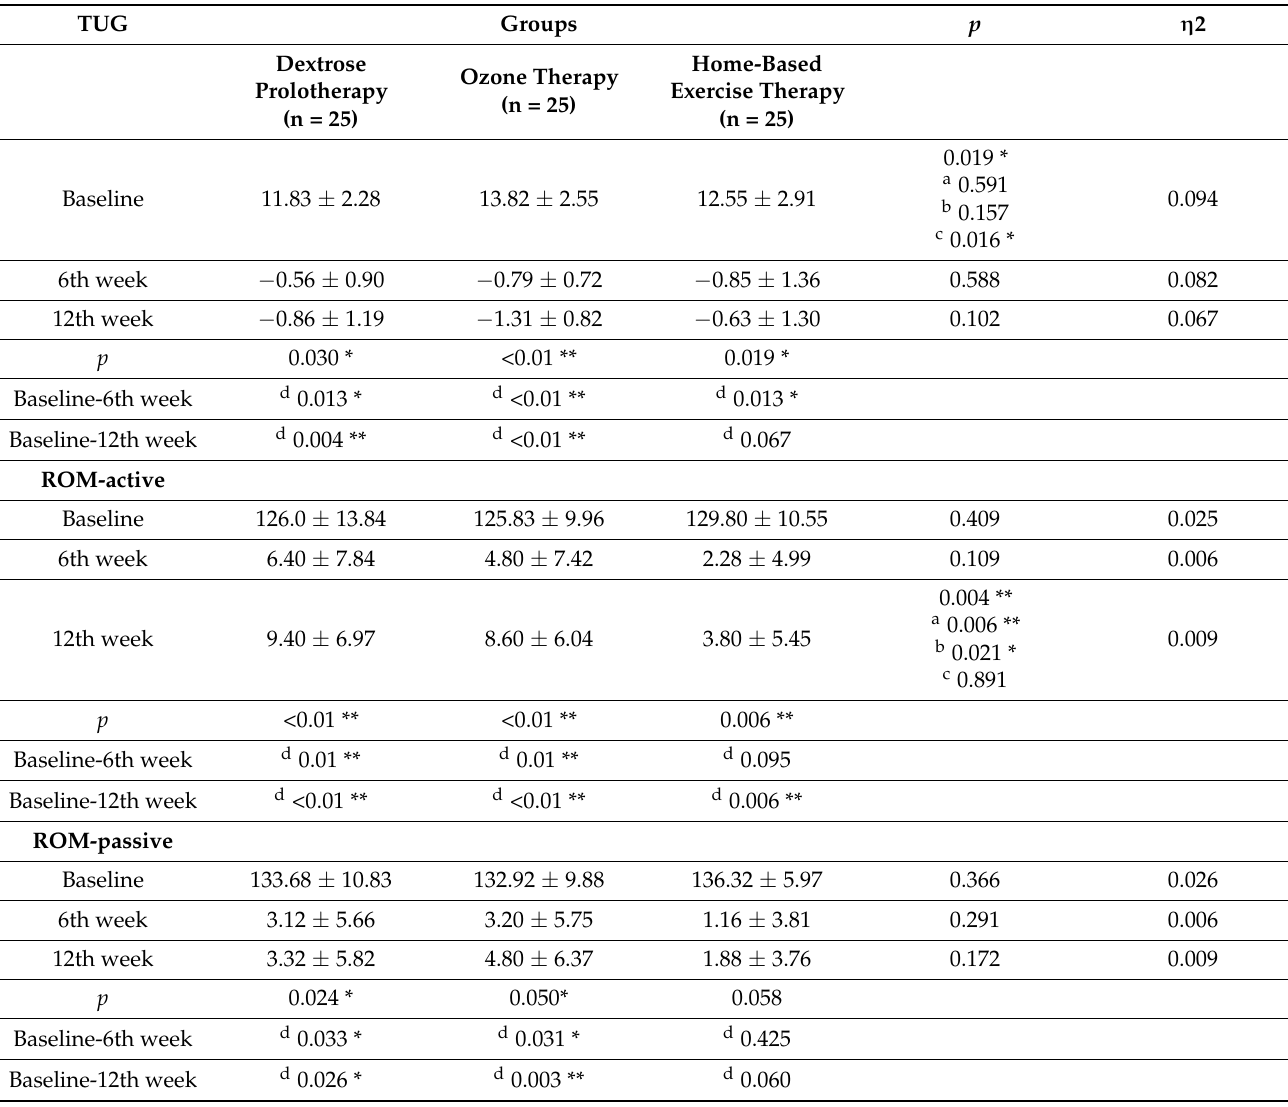
Table 4. TUG and ROM scores of groups and